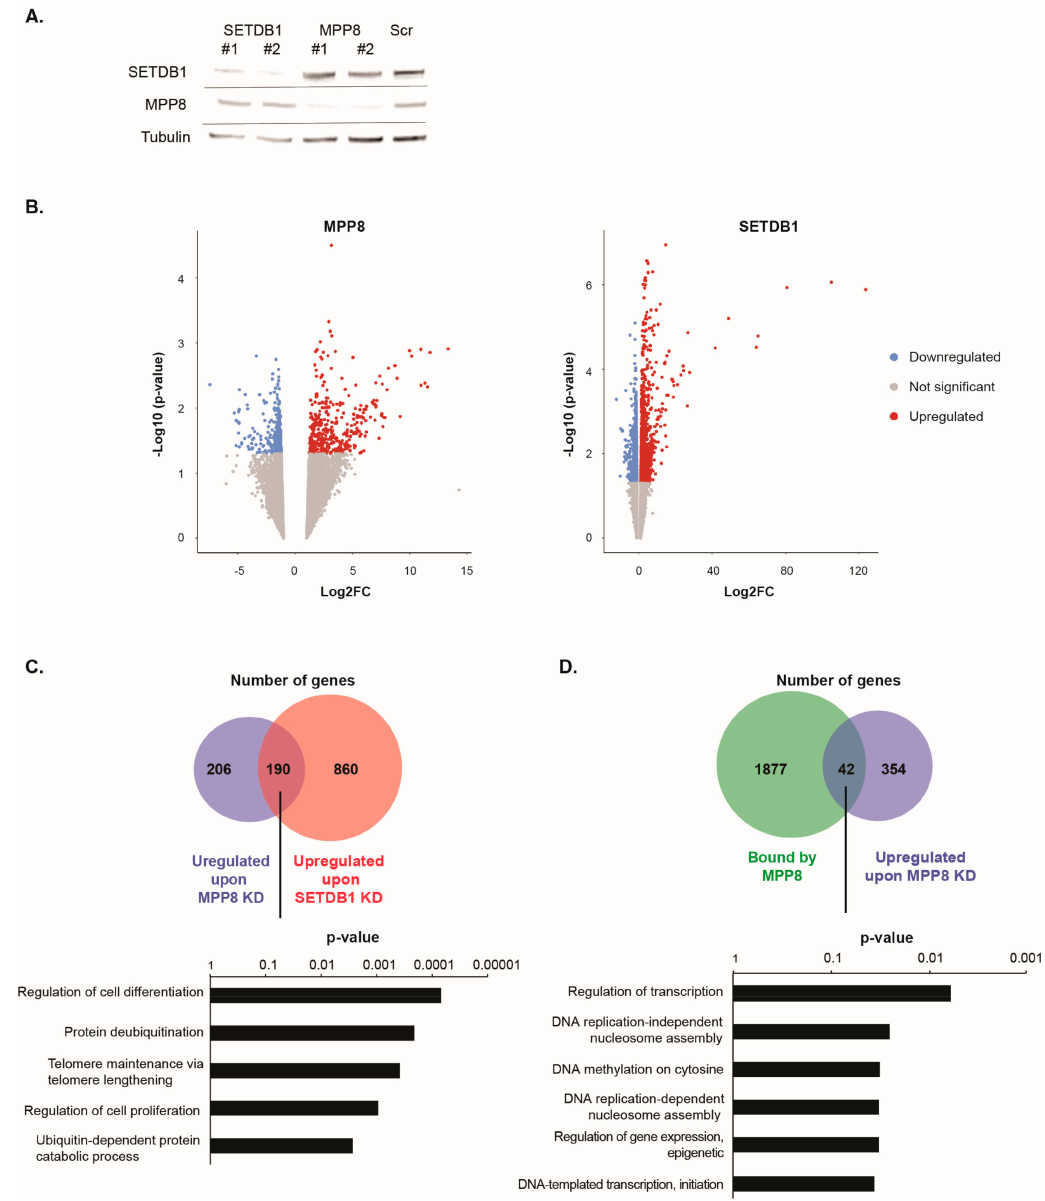
Figure 3. MPP8 and SETDB1 regulate common genes in mouse embryonic stem cells (mESCs). ( A ) Loss- of-function assays. HM1 ESCs were transfected with a scrambled control siRNA (Scr) or siRNA directed against MPP8 or SETDB1 mRNAs. The knockdown (KD) e ffi ciency as assessed by WB is presented. Two independent experiments are shown as #1 and #2. ( B ) Volcano plot representations of deregulated genes as measured by RNA-seq in HM1 ESCs upon MPP8 KD (Left panel) and upon SETDB1 KD (Right panel). Red dots indicate significantly upregulated genes and blue dots indicate significantly downregulated genes ( p -value < 0.05). ( C ) Upper panel: Venn diagram representation of upregulated genes upon MPP8 or SETDB1 KD (log2FC > 1 and p -value < 0.05). Lower panel: Gene ontology (GO) analysis of 190 overlapping upregulated genes. The top 5 biological processes are presented ( p -value < 0.05). ( D ) Upper panel: Venn diagram representation of genes bound by MPP8 in mESCs and upregulated genes upon MPP8 KD (log2FC > 1 and p -value < 0.05). Lower panel: Gene ontology (GO) analysis of 42 overlapping genes. The top 6 biological processes are